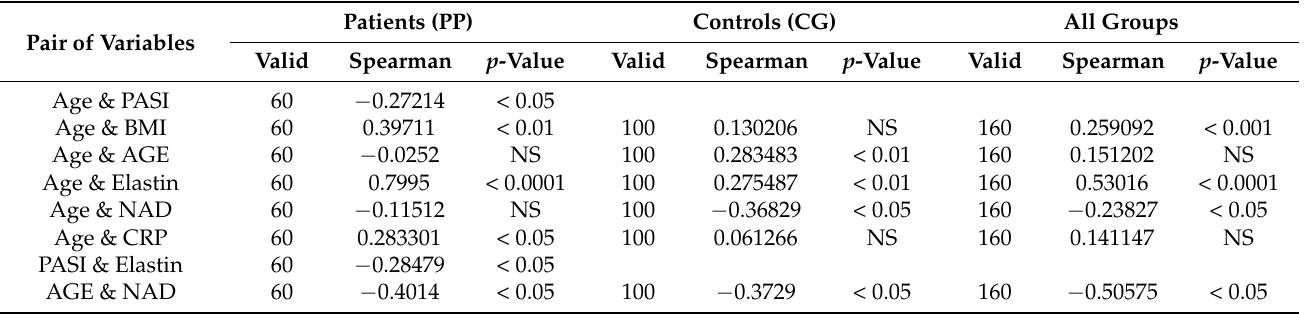
Table 3. Relationships among the tested parameters and differences between the PP and the